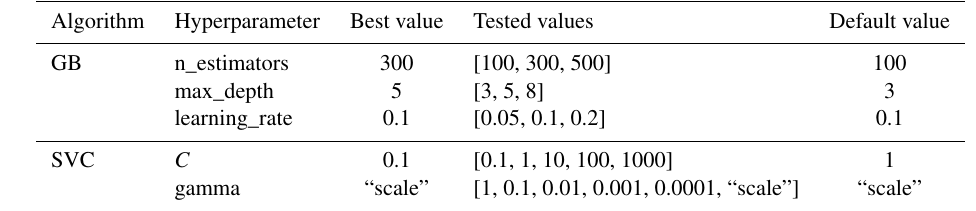
Table 3. Tuned hyperparameters of both algorithms with their best, tested and default values.